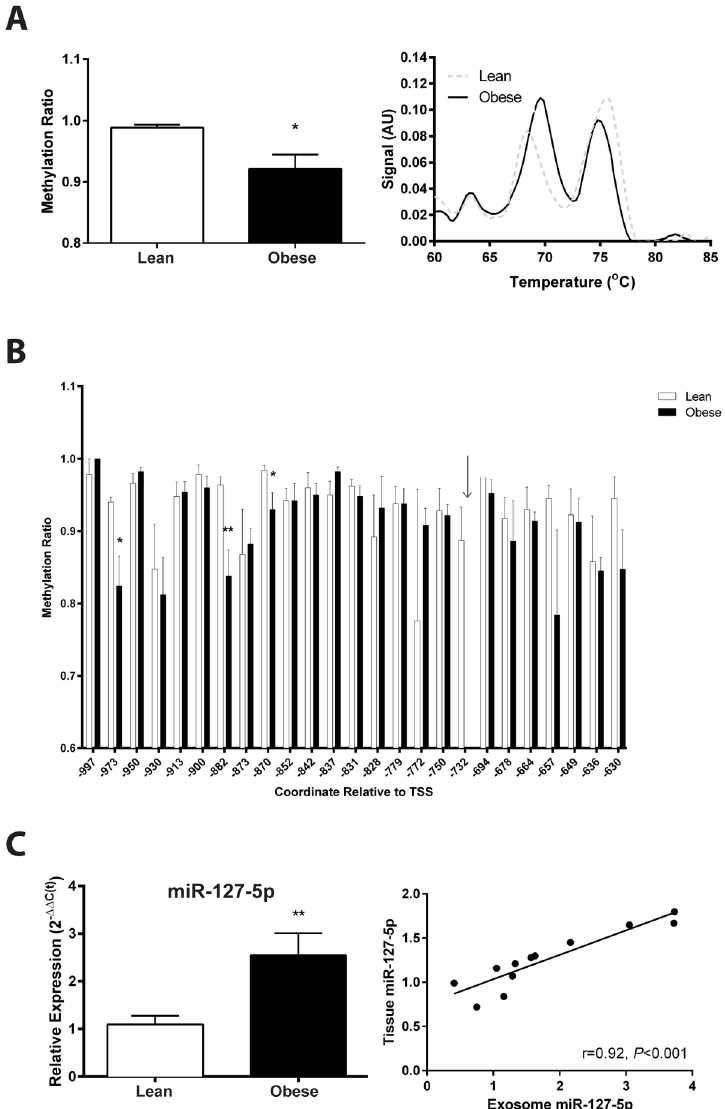
Fig 6. Epigenetic regulation and distribution of miR-127-5p. The 1kB region adjacent to the TSS of miR- 127-5p contains four CpG islands, which may be responsible for sustaining expression of the miRNA. (A) High Resolution Melt (HRM) was used to analyze overall DNA methylation status of the 1 kB region upstream of the miR-127-5p TSS in muscle biopsies in the lean (n = 6) and obese (n = 7) subjects. (B) Results from bisulfite sequencing of the first two CpG islands of the 1 kB region identified 26 methylation sites in lean (n = 5) and obese (n = 5) subjects. No results could be obtained for obese subjects at the site indicated by the arrow. (C) Total RNA was extracted from serum exosomes of lean (n = 6) and obese (n = 6) subjects, analyzed for miR-127-5p expression (left), and correlation with skeletal muscle expression was determined (right). Data shown are means ± SE, * P < 0.05 and ** P < 0.01 by Student ’ s unpaired